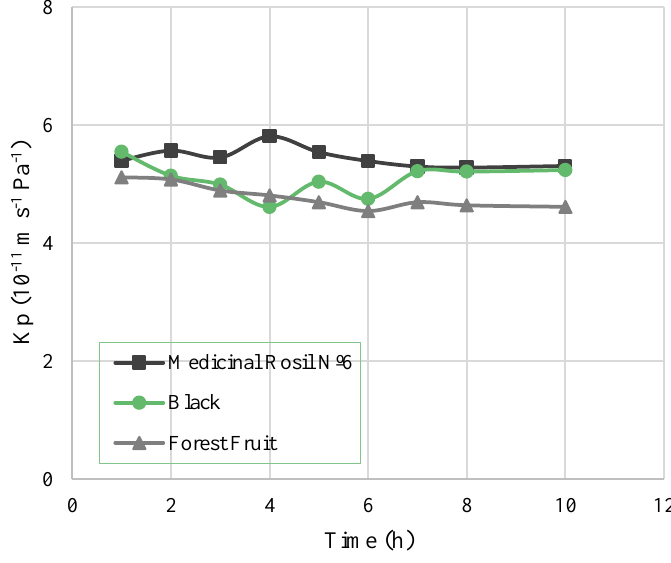
Figure 4. Overall mass transfer coefficient as a function of the time.